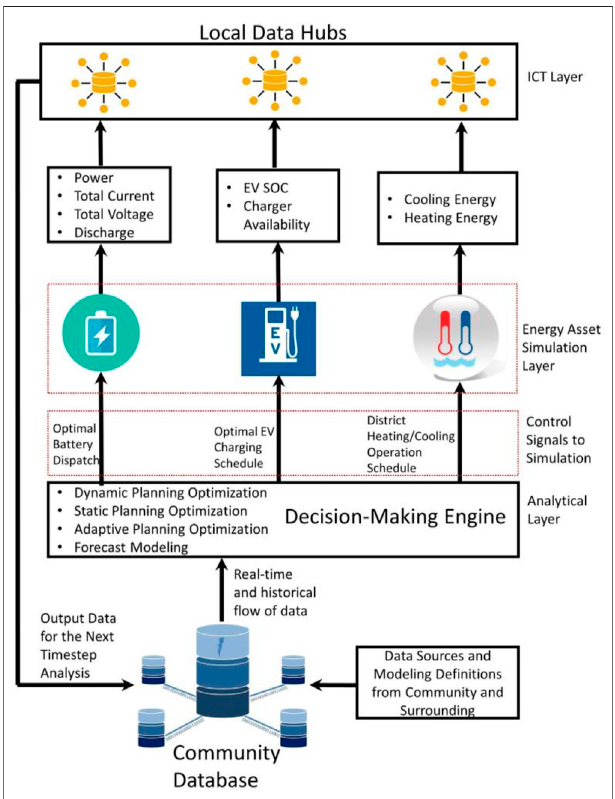
FIGURE 7 | Example of input/output data streams to control shared assets of a smart community.